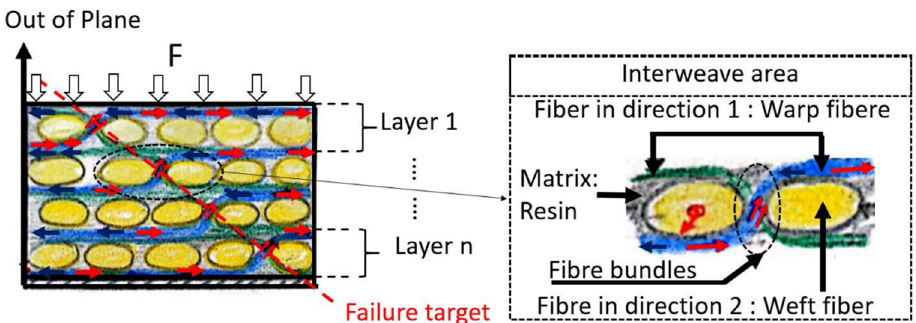
Figure 4. Illustration of out-of-plane compression failure mechanism of woven fibre composite. Red → arrow and blue ← arrow: local normal forces transferred to fibre due to Poisson effect. Double red arrow: Forces in fiber bundles zone which is a combination of shear, tensile and compression forces. ↓ Black arrow: compression-loading force. Dash red line: Failure target. For bswFRC, the mechanical stress concentration is in interweave zone (bundle zone). Thus, the failure target across this bundle zone.